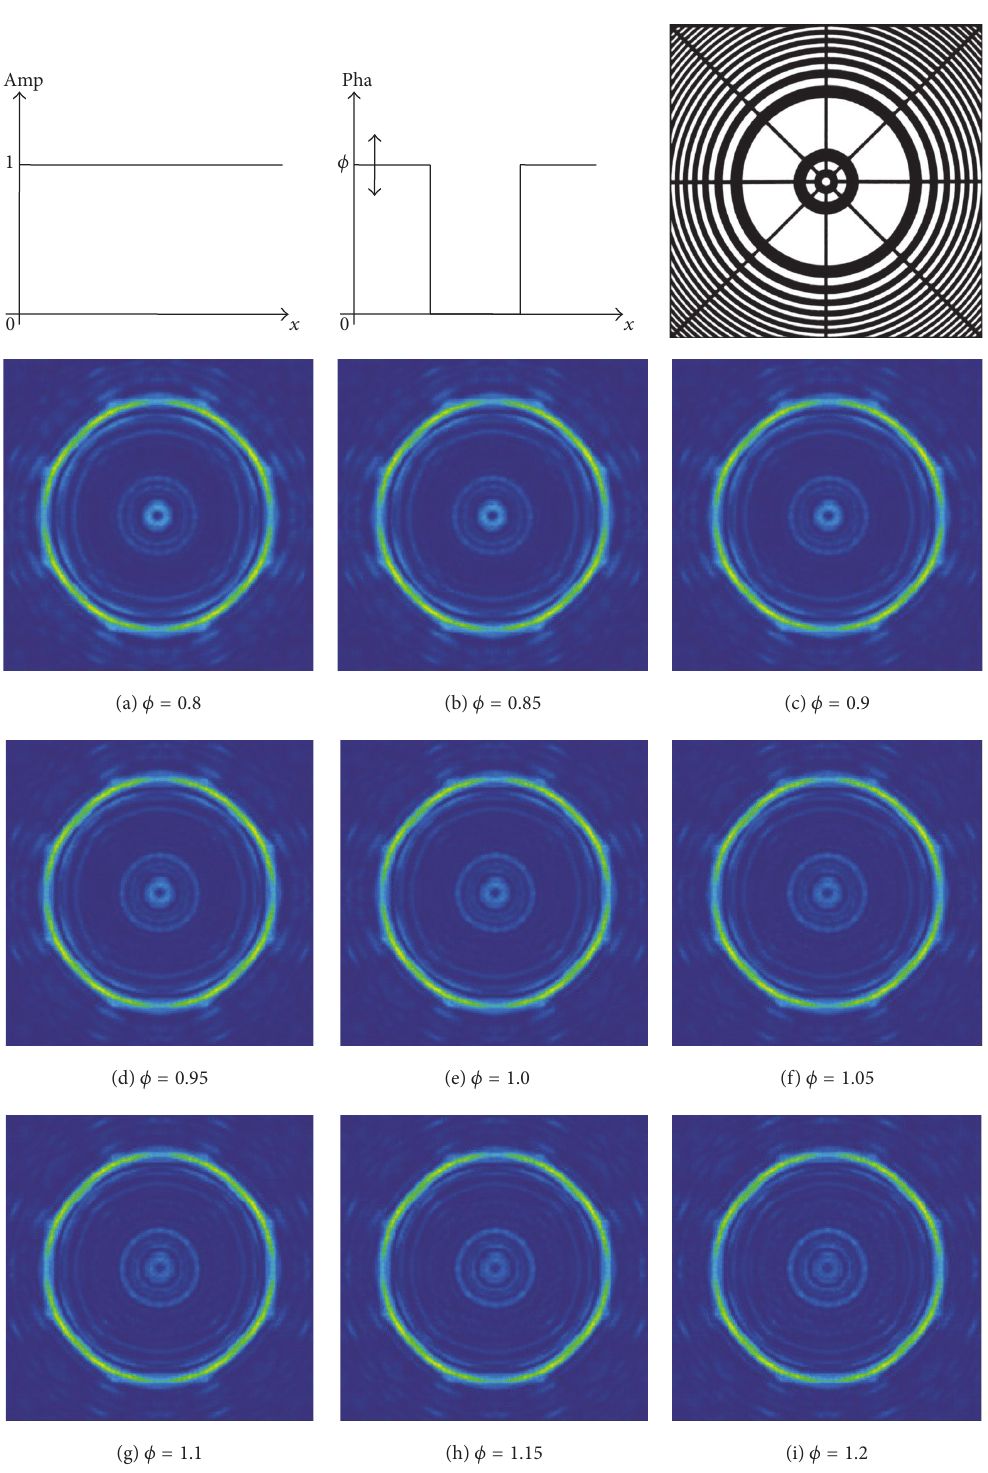
Figure 7: The simulation parameters (amplitude and phase diagrams together with the structure’sphase distribution). Intensity distributions (simulation results) for different phase mismatch for scanned structure. Simulations were conducted for introduced phase delay as follows: 0.8, 0.85, 0.9, 0.95, 1.0, 1.05, 1.1, 1.15, and 1.2, shown in (a)–(i),